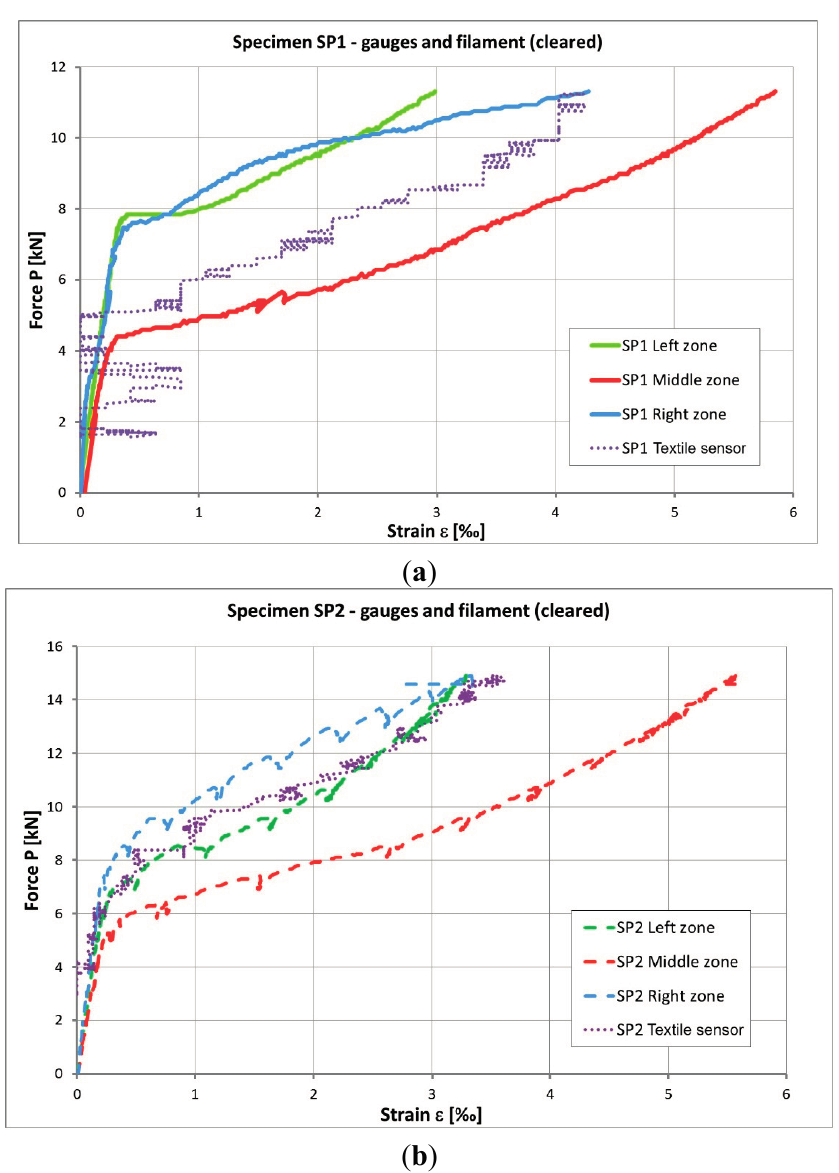
Figure 10. Strain—Load relationships for: ( a ) specimen SP1 and ( b ) specimen